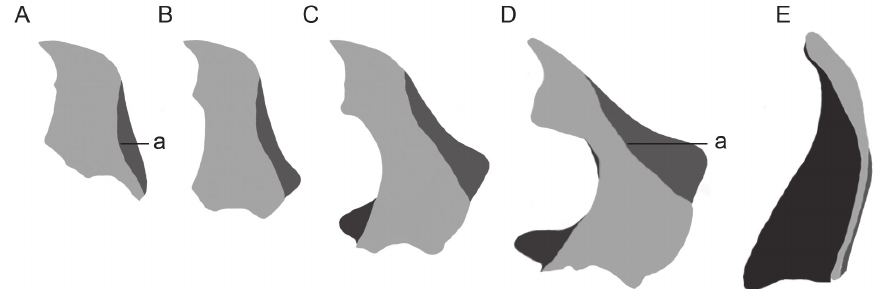
Figure 3. Dorsal view male mandibles; light grey, dorsal surface; dark grey, ventral external concavity; black, interior surface; a, dorso-lateral border; mandibles of A and D are drawn from specimens that were digitally scaled until they had similar body length A Hexamitodera semivelutina B, C hypothetical inter- mediate forms D Hexamitodera ( Sulcognatha ) blairi comb. n. e Parandrocephalus eversor